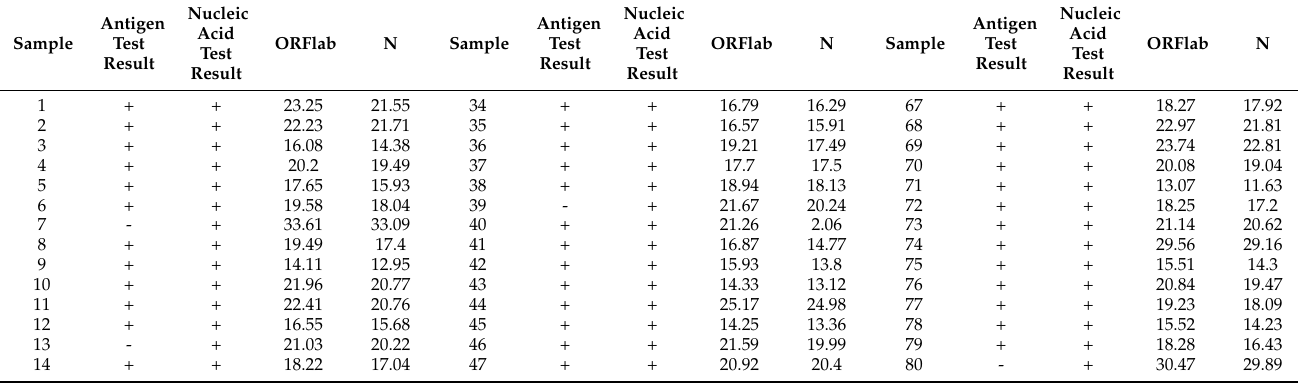
Table 8. Comparison table of Chengdu Public Health Clinical Medical Center antigen detection and nucleic acid detection